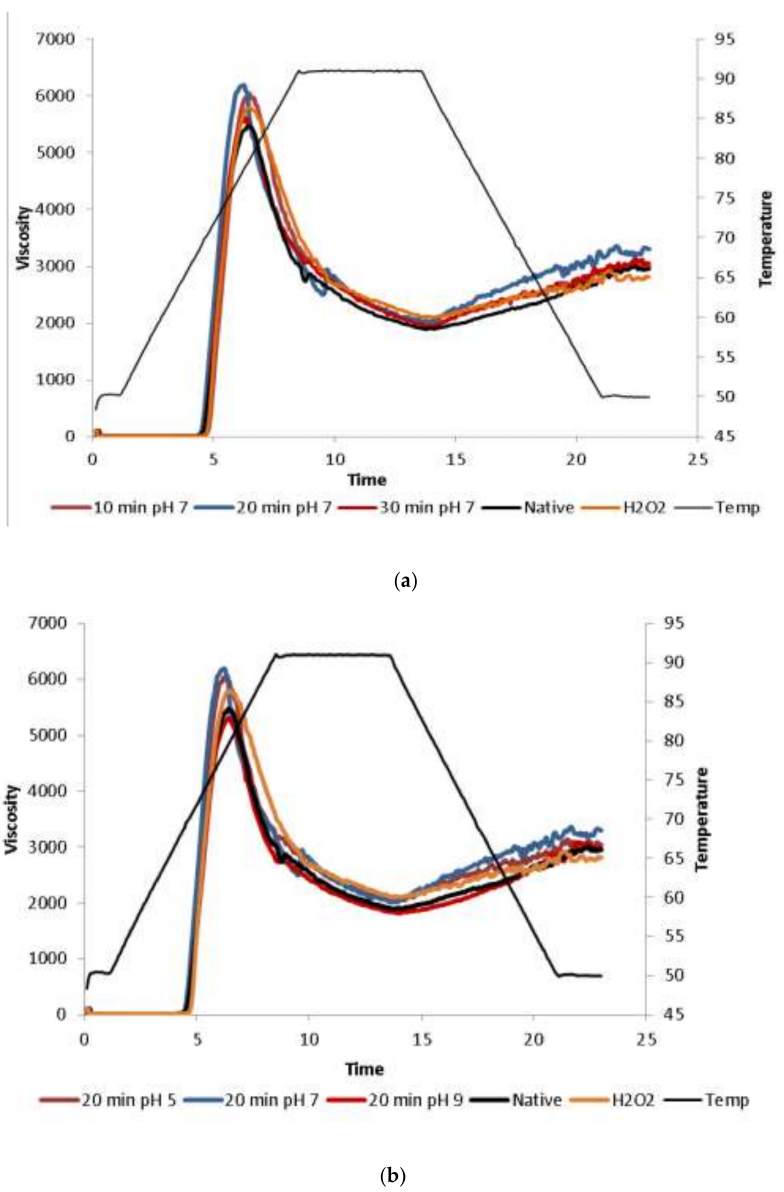
Figure 1. RVA curve of ozone-oxidized tapioca with different oxidation time at pH 7 ( a ) and different pH for 20 min ( b ) compared with native and H 2 O 2- oxidized